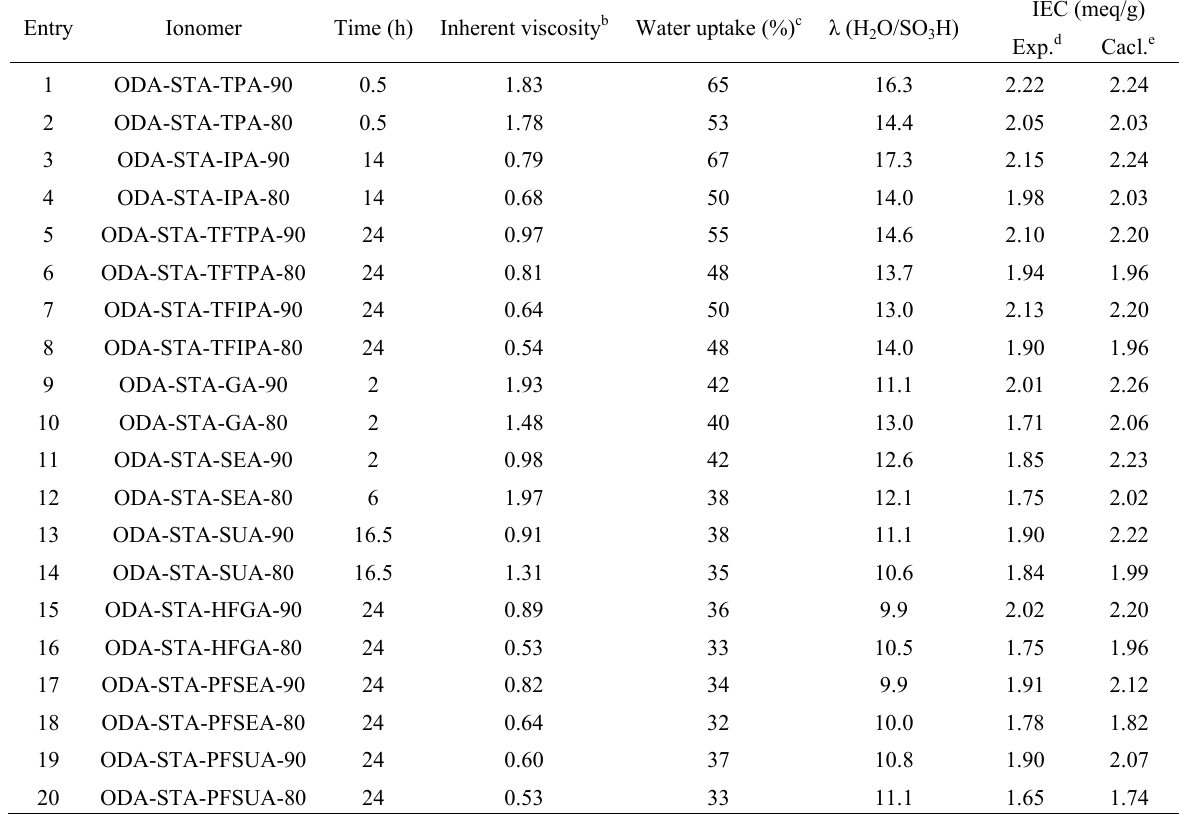
Table 1. Polymerization conditions and properties of sulfonated poly(ether amide) membranes a